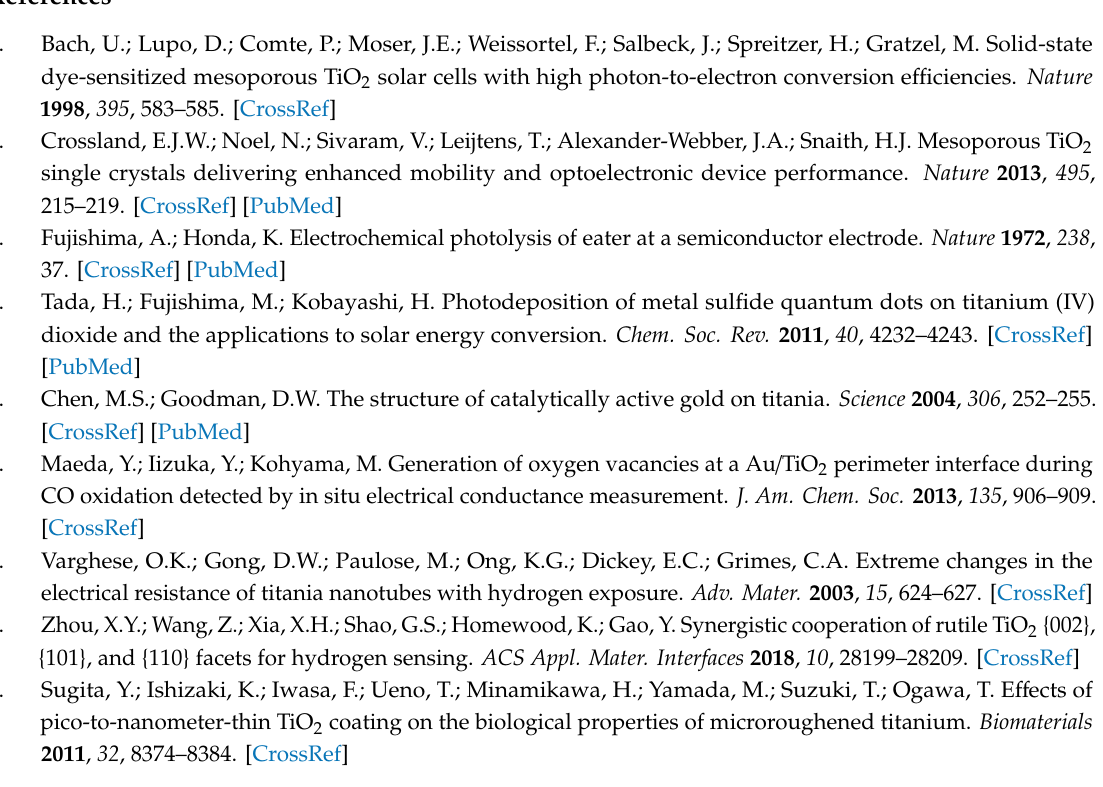
Figure S1: H 2 dissociation on rutile TiO 2 (100) facets with U = 4 eV and U = 0 eV. Figure S2: H 2 dissociation on rutile TiO 2 (110) facets with U = 4 eV and U = 0 eV. Figure S3: H 2 dissociation on rutile TiO 2 (101) facets with U = 4 eV and U = 0 eV. Figure S4: Projected Density of State (PDOS) of the TiO 2 slab, H 2 *, TS, and (H + , H − ), (H + -H + ) for the (110) (left) and (101) (right) surfaces. Figure S5: Spin Density of TS2 and (H + -H + ). Figure S6: Structures of (H + -H − ) for the other adsorption modes considered. Tables S1–S6 and Figures S7–S11 IR frequencies. Tables S7 and S12: Grimme D3 corrections. Geometric structures for the intermediates and transition structures used in this work (POSCAR - VASP input files-